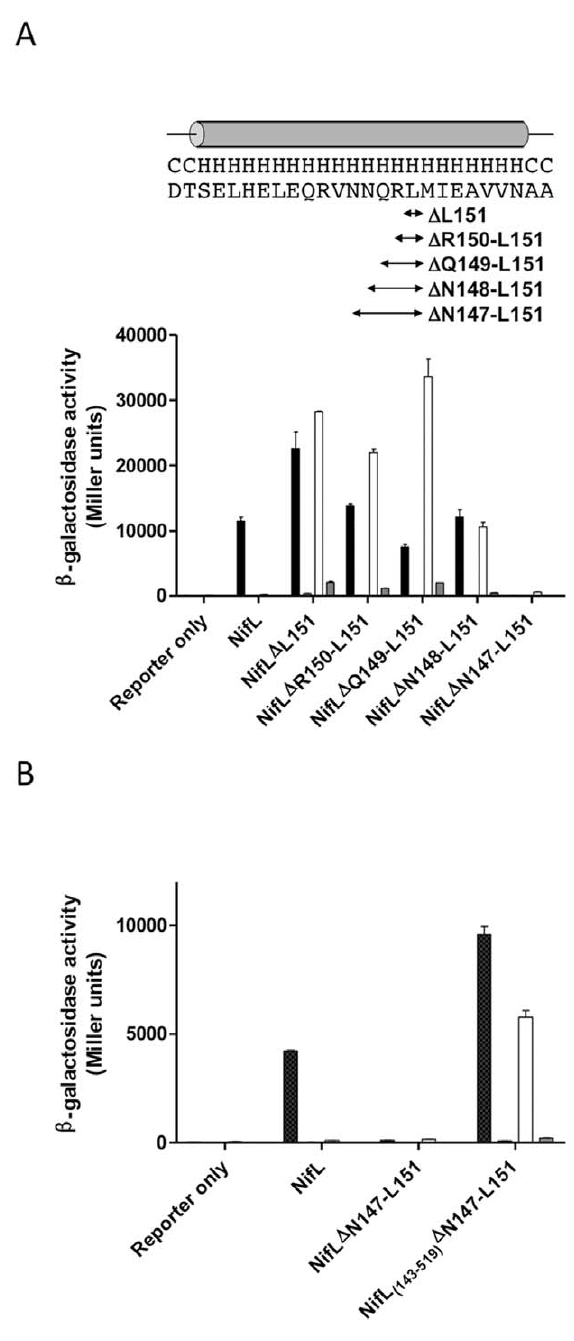
Figure 4. Influence of deletions in the a -helical linker connecting PAS1 and PAS2 on NifL activity. (A) Effect of linker deletions (indicated on the x axis) on the ability of NifL to control NifA activity (y axis). The sequence of the linker and the extent of the deletions are indicated above the graph. (B) Requirement for presence of the PAS1 domain for the ‘‘locked on’’ phenotype exhibited by the D N147-L151 deletion. Cultures were assayed for b -galactosidase activity as a reporter of NifA-mediated transcriptional activation from the nifH p - lacZ fusion on plasmid pRT22 as described previously [12]. Cultures were grown under the following conditions; anaerobically under nitrogen limitation with casein hydrolysate as the sole nitrogen source (black bars), aerobically with casein hydrolysate as sole nitrogen source (white bars) and aerobically with (NH 4 ) 2 SO 4 as nitrogen source (grey bars). (Cultures were also grown anaerobically in the presence of (NH 4 ) 2 SO 4 , but activities were too low to display on this scale). doi:10.1371/journal.pone.0046651.g004 PLOS ONE |